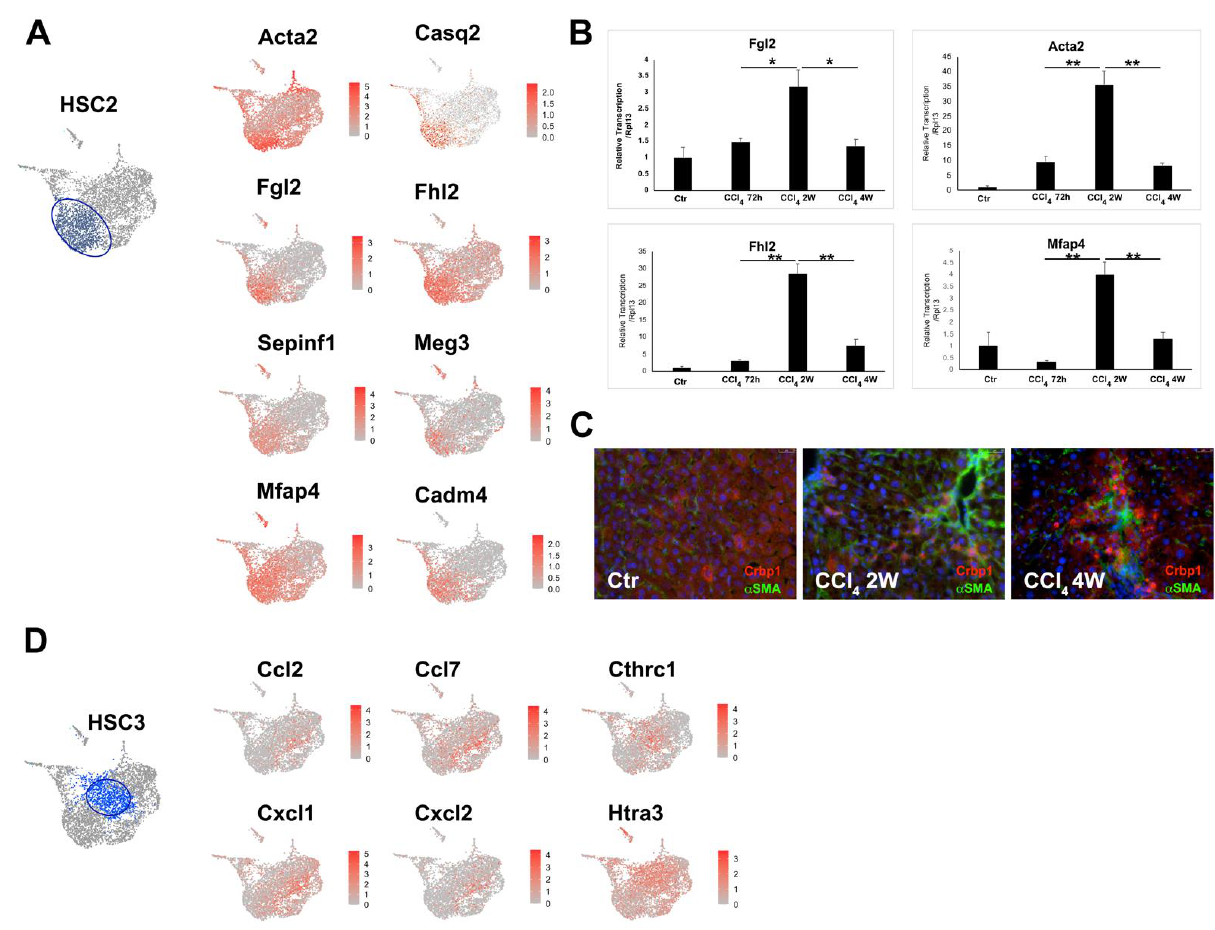
Figure 4. HSC2 and HSC3 are the two major HSC1 derived HSC subtypes in the CCl 4 -treated mouse liver. ( A ) Representative Loupe images of the expression pattern of the selected HSC2 marker genes. Each dot represents one cell. The blue dots (left) represent HSC2 cells. ( B ) qRT-PCR analysis of the representative HSC2 marker genes in mouse liver treated with CCl 4 for 72-h, 2-week (2 w) and 4-week (4 w), respectively. t -test analysis, * p < 0.05, ** p < 0.01. ( C ) Co-Immunofluorescent staining of Crbp1 and aSMA2 in control (Ctr), 2 w and 4 w of CCl 4 treated mouse liver (200 × ). ( D ) Representative Loupe images of the expression pattern of selected HSC3 marker genes. Blue dots (left) represent HSC3 cells.